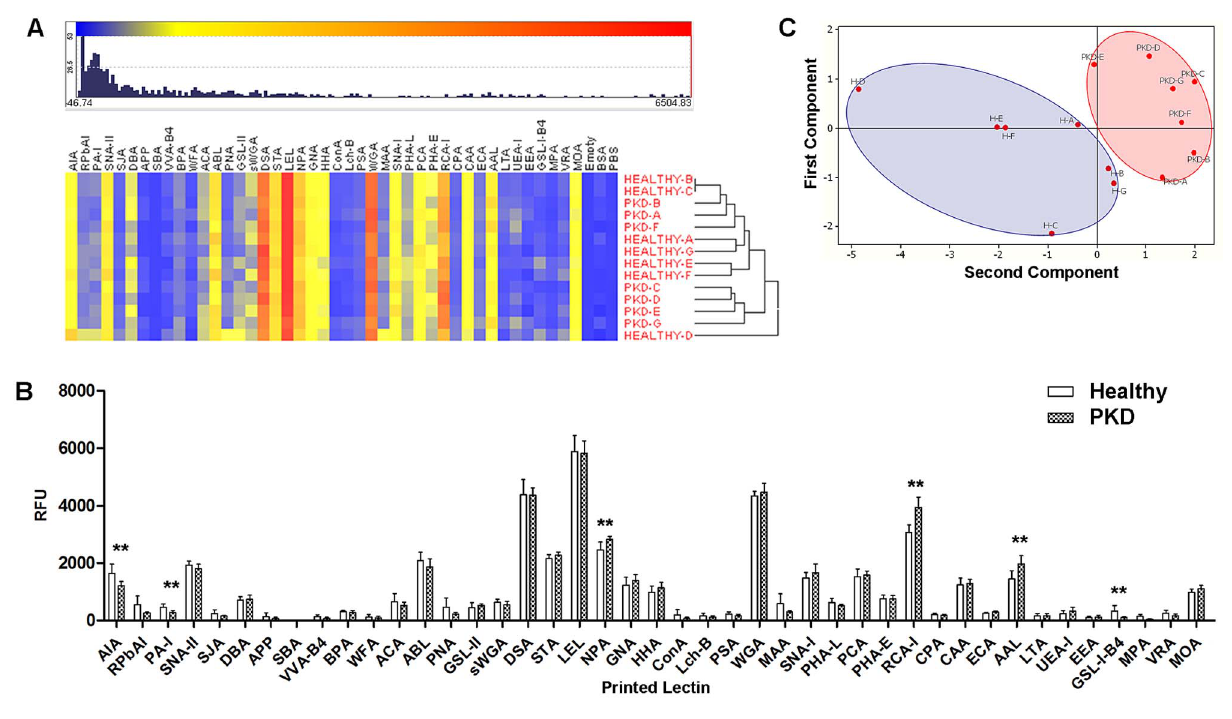
Figure 8. Comparison of ADPKD uEV profiles and matched controls. ( A ) Heat map and distribution of intensities for clustered ADPKD gUC- uEV (PKD) mean normalized lectin array responses and age-matched gUC-uEV controls (HEALTHY). Mean data representative of 3 (H-A, H-B, H-D, H-E, H-F, H-G) or 2 (H-C) technical replicates for the indicated 7 healthy uEV samples and of 4 technical replicates for the 7 ADPKD (PKD-A through PKD-G) uEV samples. ( B ) Comparison of pooled responses (all PKD data combined vs all HEALTHY combined). Error bars represent 6 average deviation. Significance (**= p # 0.01) determined by paired, two-tailed Student’s t-tests of individual lectin responses. ( C ) Score plot generated from data of the 6 significant lectin responses indicated in (B) showing grouped ADPKD (PKD, red oval) and matched healthy (H, blue oval)